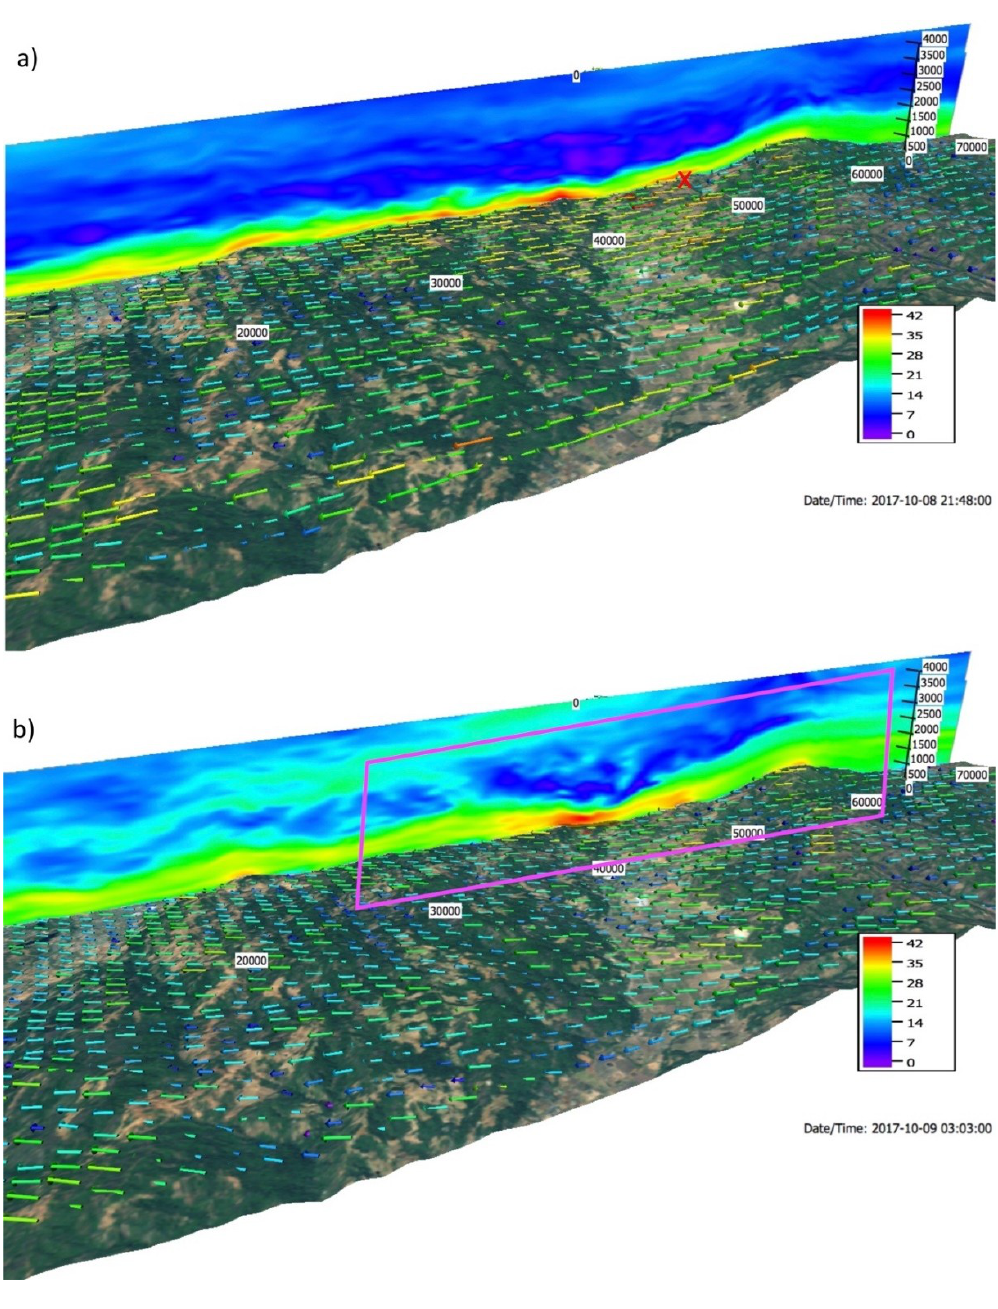
Figure 11. Cross-section through the retrospective research simulation of the Tubbs Fire ( a ) at 9:48 p.m. on 8 October, near the ignition time; and ( b ) at 3:03 a.m. on 9 October. Figures show an along-flow vertical cross section through the ignition (shown in ( a ) as a red X) while the contoured field is the simulated wind speed in the plane (in m/s), colored according to the color bar at right. Wind speed arrows (in m/s) point downstream and are shown every three grid points. The magenta box shows the area resembling a hydraulic jump at this time step, although speed maxima move through the cross section from right to left and the depth of the high-speed region dips over it.